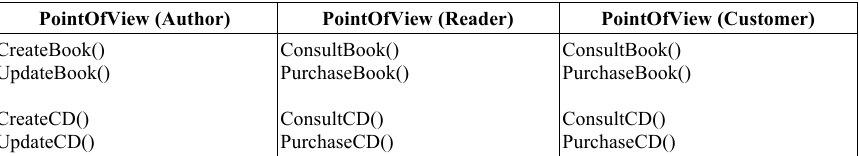
Table 4. Automatically generated Points of view of the Online Library study case